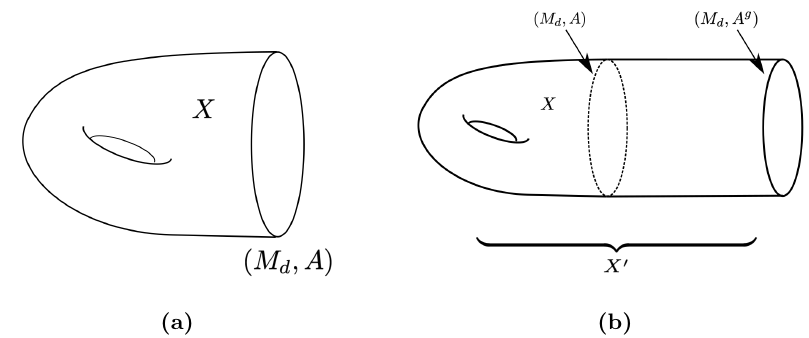
Figure 2. Extensions of (a) ( M d , A ) and (b) ( M d , A g ) to ( d + 1)